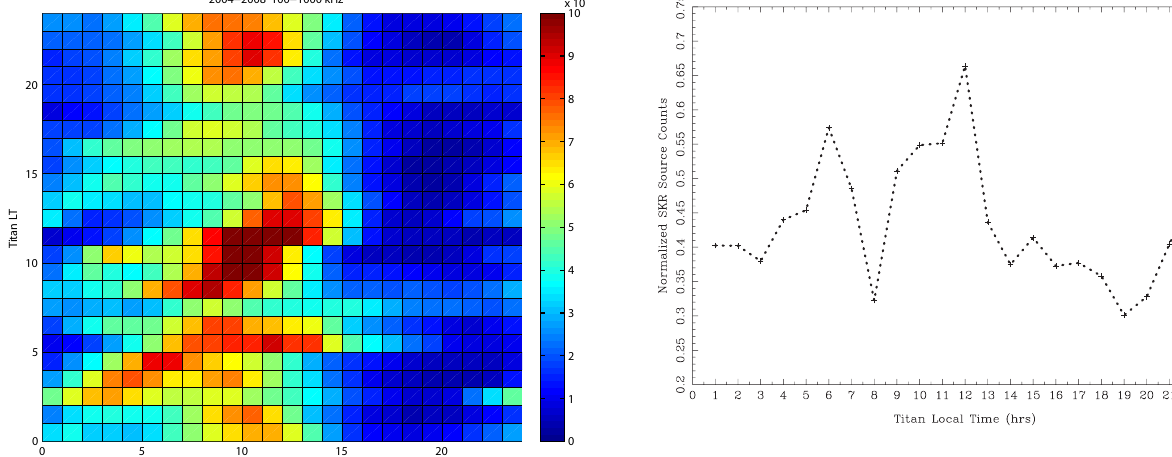
Figure 7a Fig. 7a. A cut or slice of Fig. 6 showing the normalized number of counts versus Titan local time. For each 1-h bin of Titan LT in Fig. 6. Titan local time versus local time of SKR source location. Fig. 6 we calculate the average of all 1-h bins of SKR source LT Figure 6 The bins size is 1h × 1h and the number of times a source location over the range 06:00h to 14:00h SKR source LT. The peaks appear falls within a bin is color coded. The plot covers the time period as described in the text. from day 170 of 2004 to day 366 of 2008, and a frequency range of 100–1000kHz.